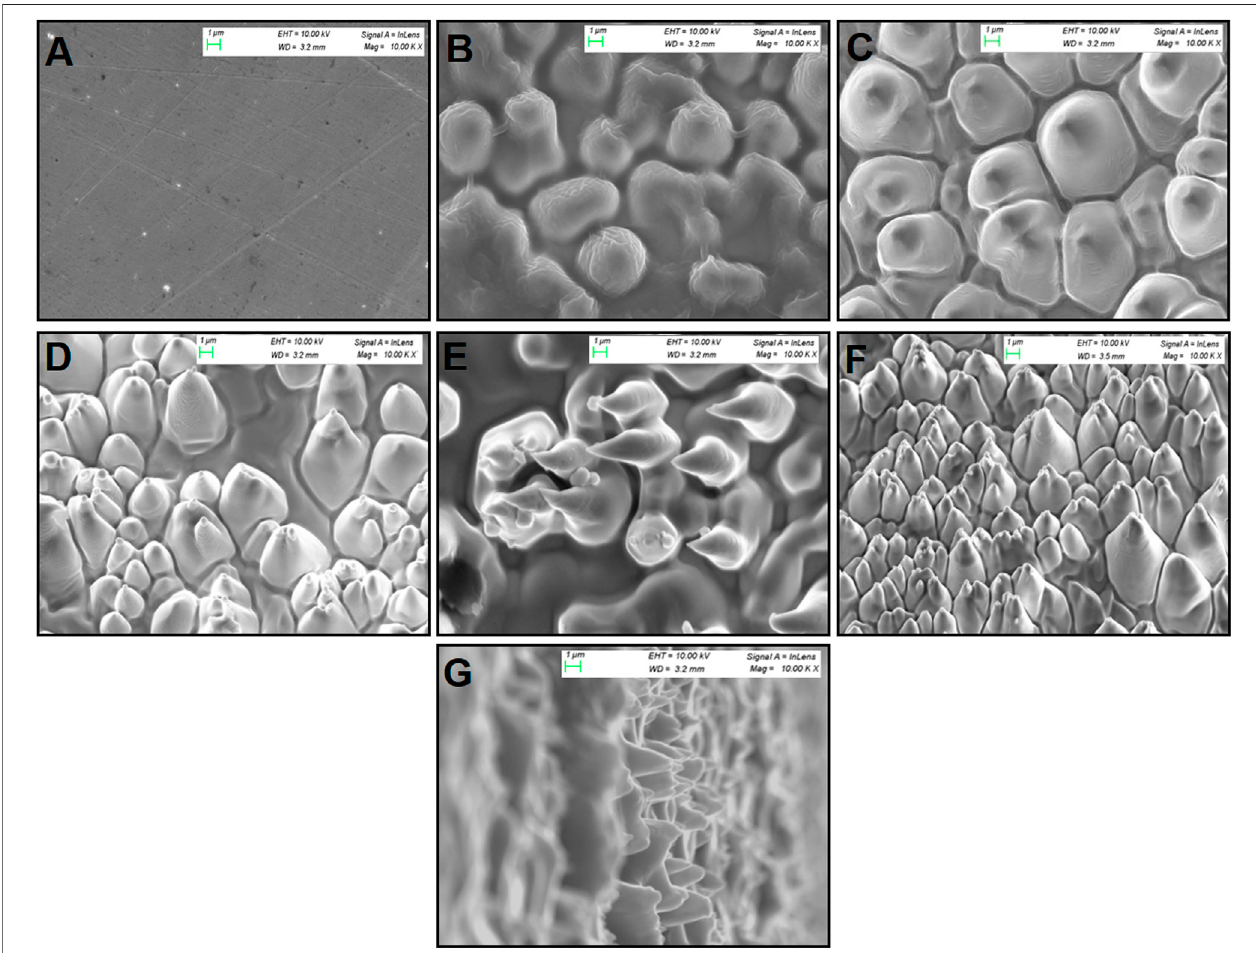
FIGURE3| SEMimages(10 μ m × 10 μ mscanarea)of (A) pristineCusheet,2 keVAr + bombardedCusheetatnormalincidencewith fl uence; (B) 1.3 × 10 18 cm − 2 , (C) 2.7 × 10 18 cm − 2 , (D) 3.2 × 10 18 cm − 2 , (E) 3.9 × 10 18 cm − 2 , (F) 4.7 × 10 18 cm − 2 , and (G) cross-sectional SEM at 4.7 × 10 18 cm − 2